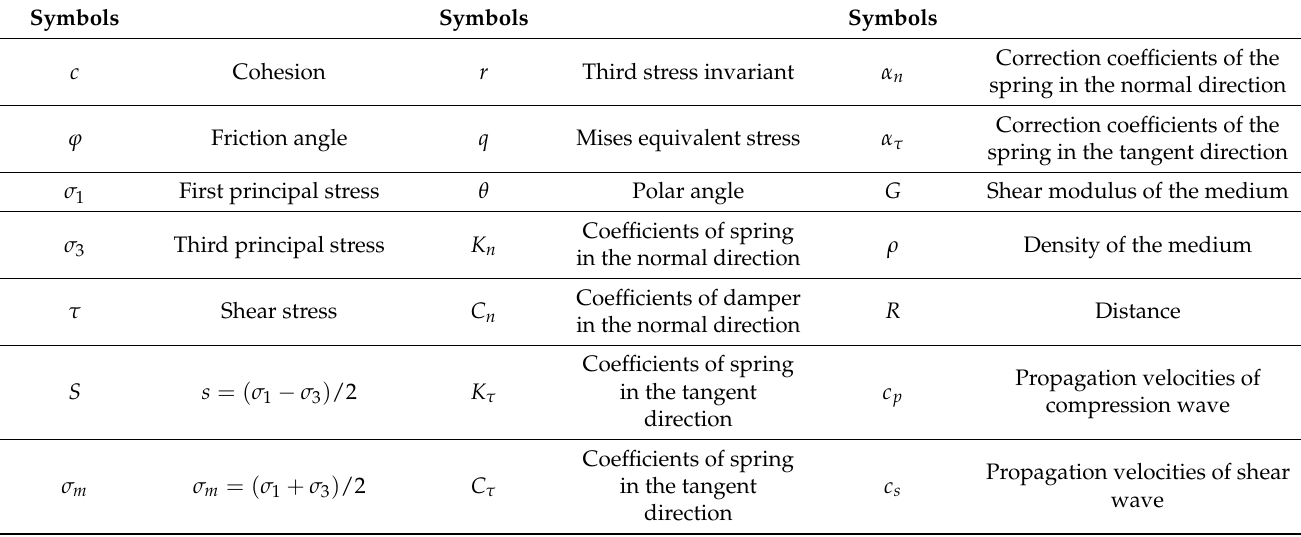
Table 1. List of symbols in